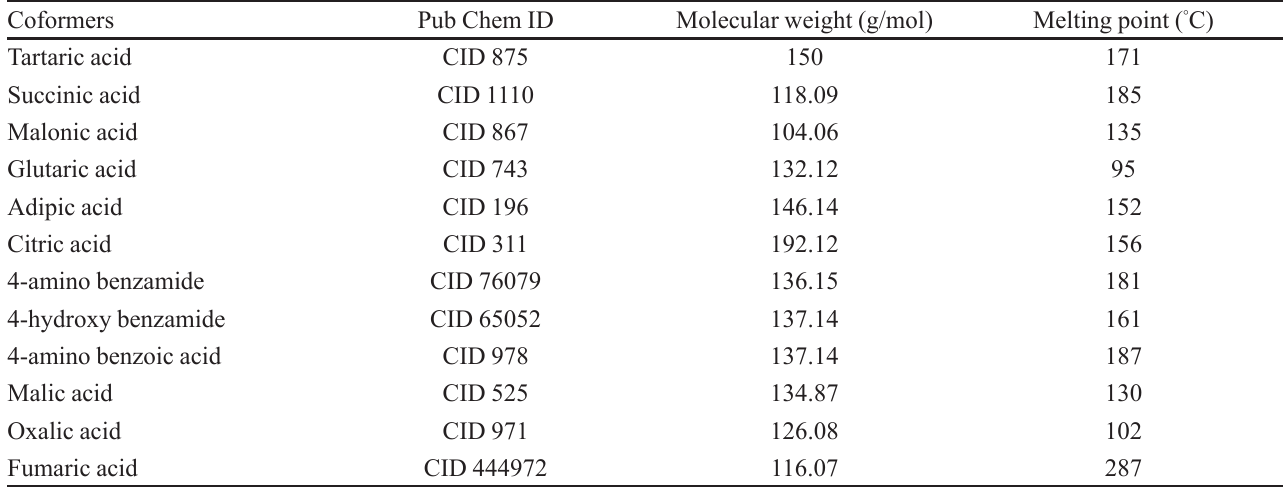
TABLE II - Physical properties of cocrystal formers